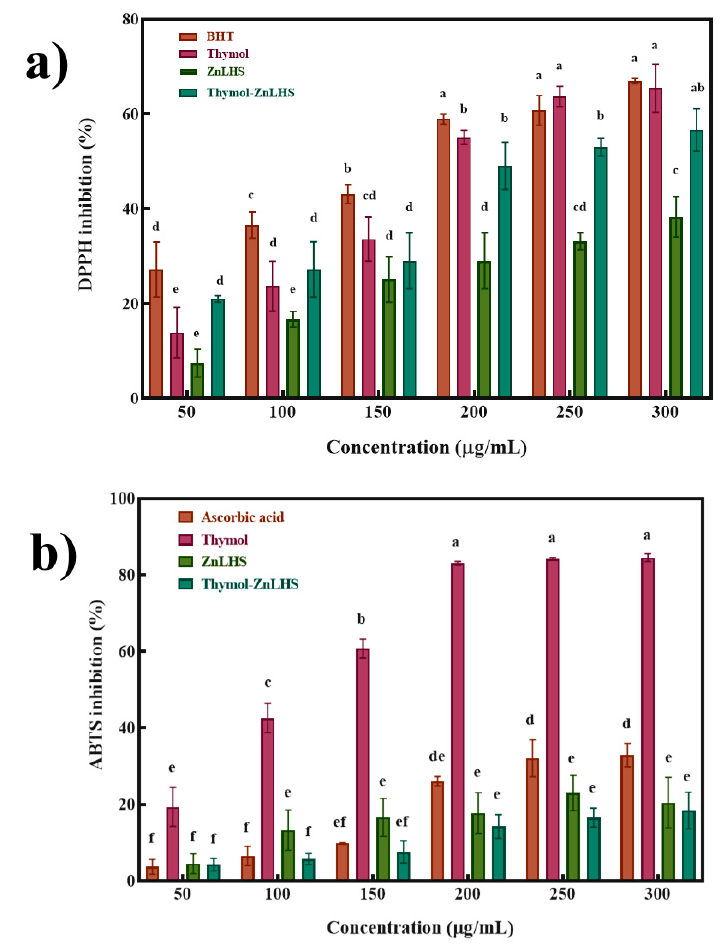
Figure 8. Antioxidant capacity of thymol, ZnLHS, and thymol–ZnLHS: ( a ) DPPH inhibition (%) and ( b ) ABTS inhibition (%). For DPPH and ABTS assays, different letters are significantly different at a p < 0.05.